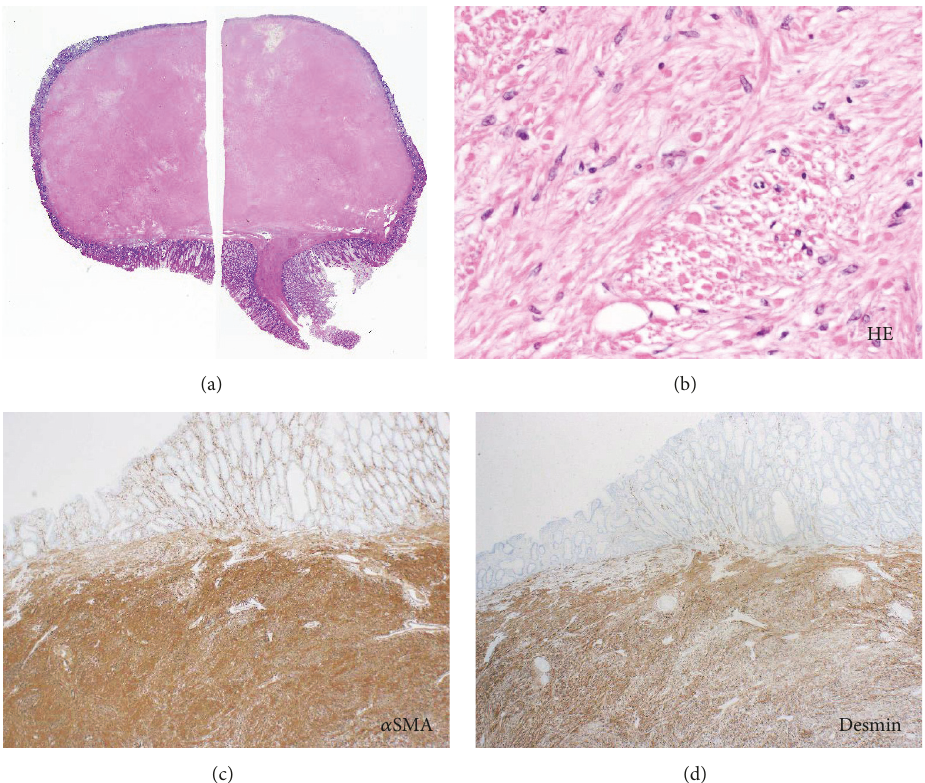
Figure 4: Pathological images of Case 2. Spindle cells with round to oval nuclei are observed in the resected specimen ((a), × 4, (b), × 400). The tumor cells are positive for 𝛼 -SMA ((c), × 100) and desmin ((d), ×